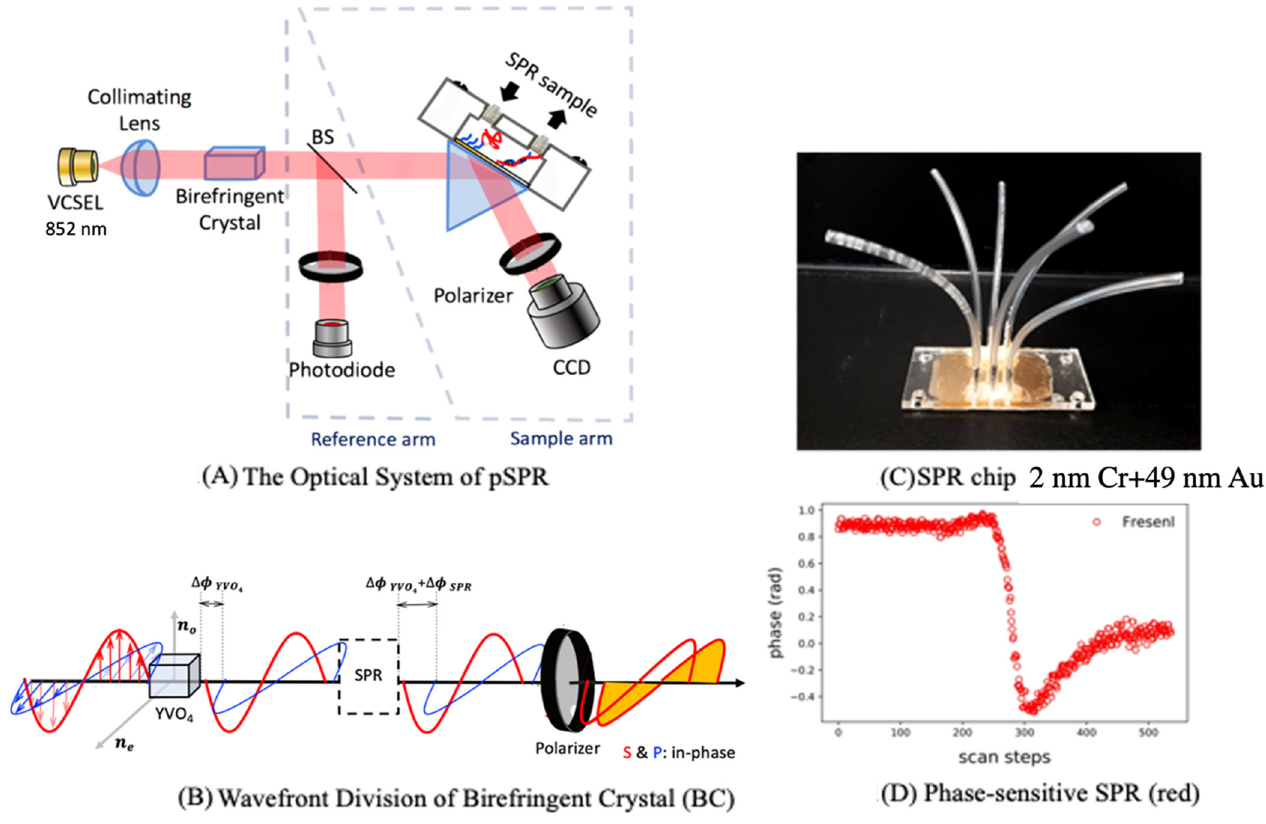
Figure 1. ( A ) Setup of the phase-sensitive surface plasmon resonance (pSPR) system. ( B ) Wavefront division of the birefringent crystal. ( C ) SPR chip. ( D ) Phase-sensitive SPR scan steps.